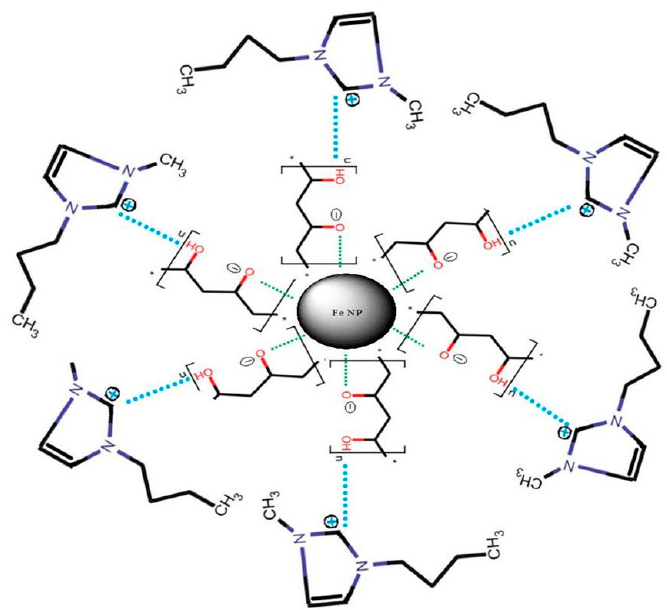
Figure 1. The supra molecular structure of the composite iron nanoparticle.